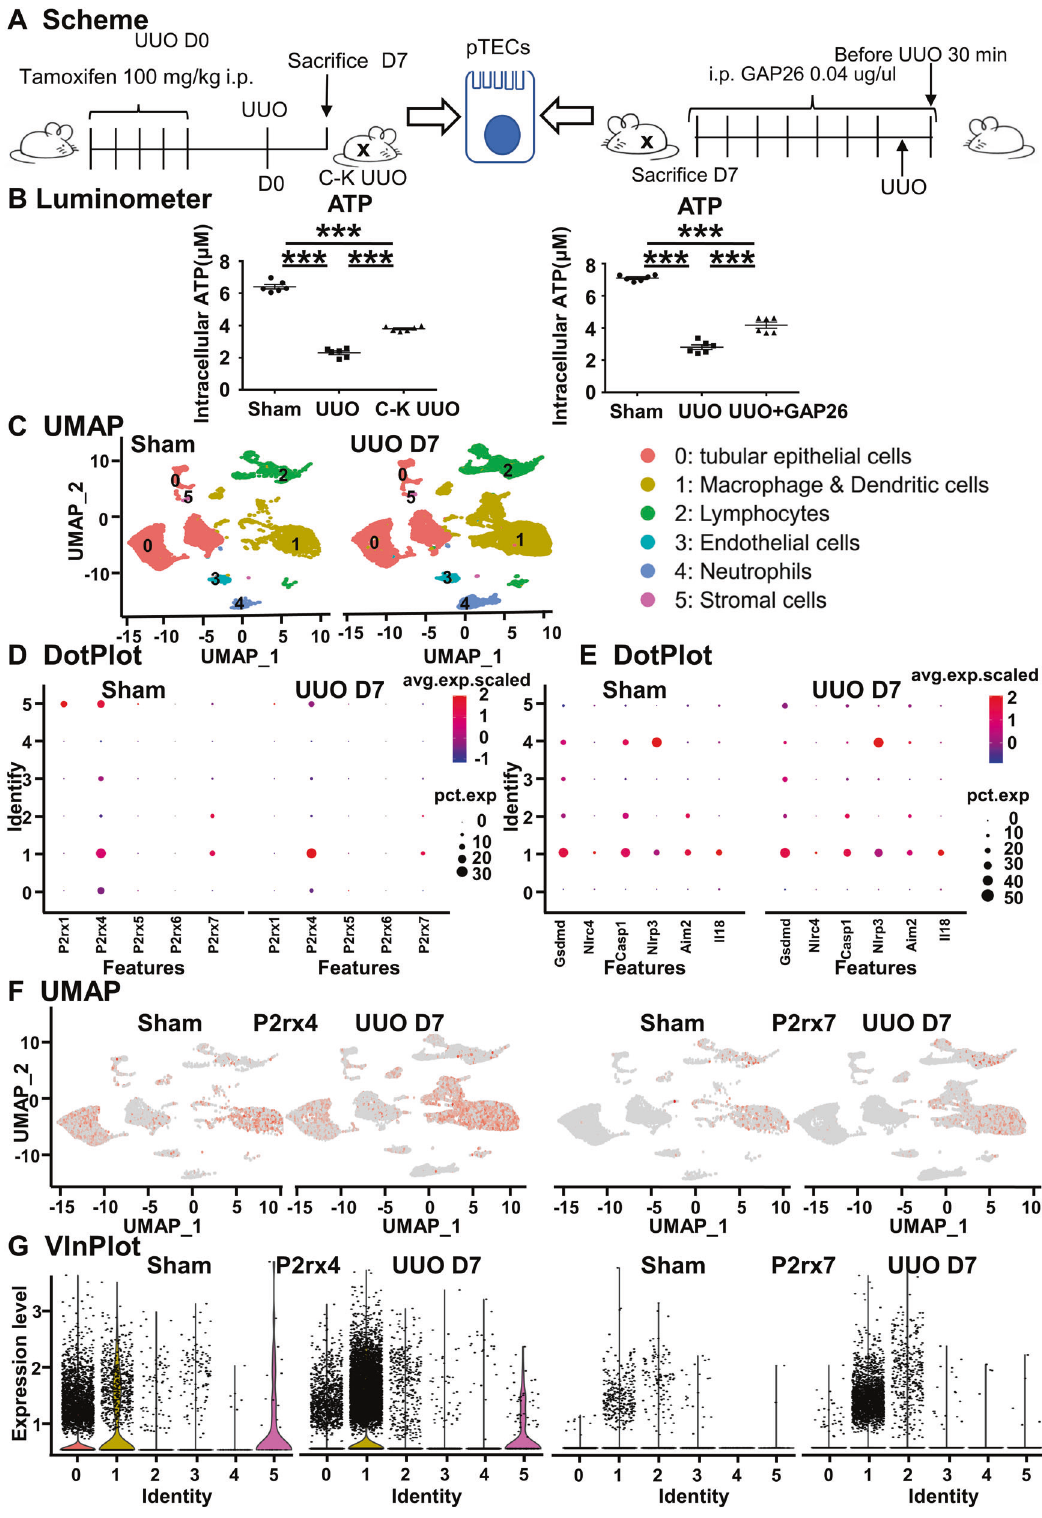
Fig. 5 The Cx43 hemichannel of TECs mediate ATP out fl ow and ATP receptor analysis. A , B Detection of intracellular ATP content in TECs. C scRNAseq identi fi ed clusters of cells in the Sham and UUO kidneys after surgery at day 7. UMAP plot representation of 30,788 kidney cells, including 20,590 cells from UUO kidney and 10,198 cells from Sham kidney. DotPlot ( D , E ), UMAP ( F ) and violin plots ( G ) depicted genes related to ATP receptor and pyroptosis. Data are presented as the mean ± SEM, n = 4 – 7/group, *** P < 0.001.